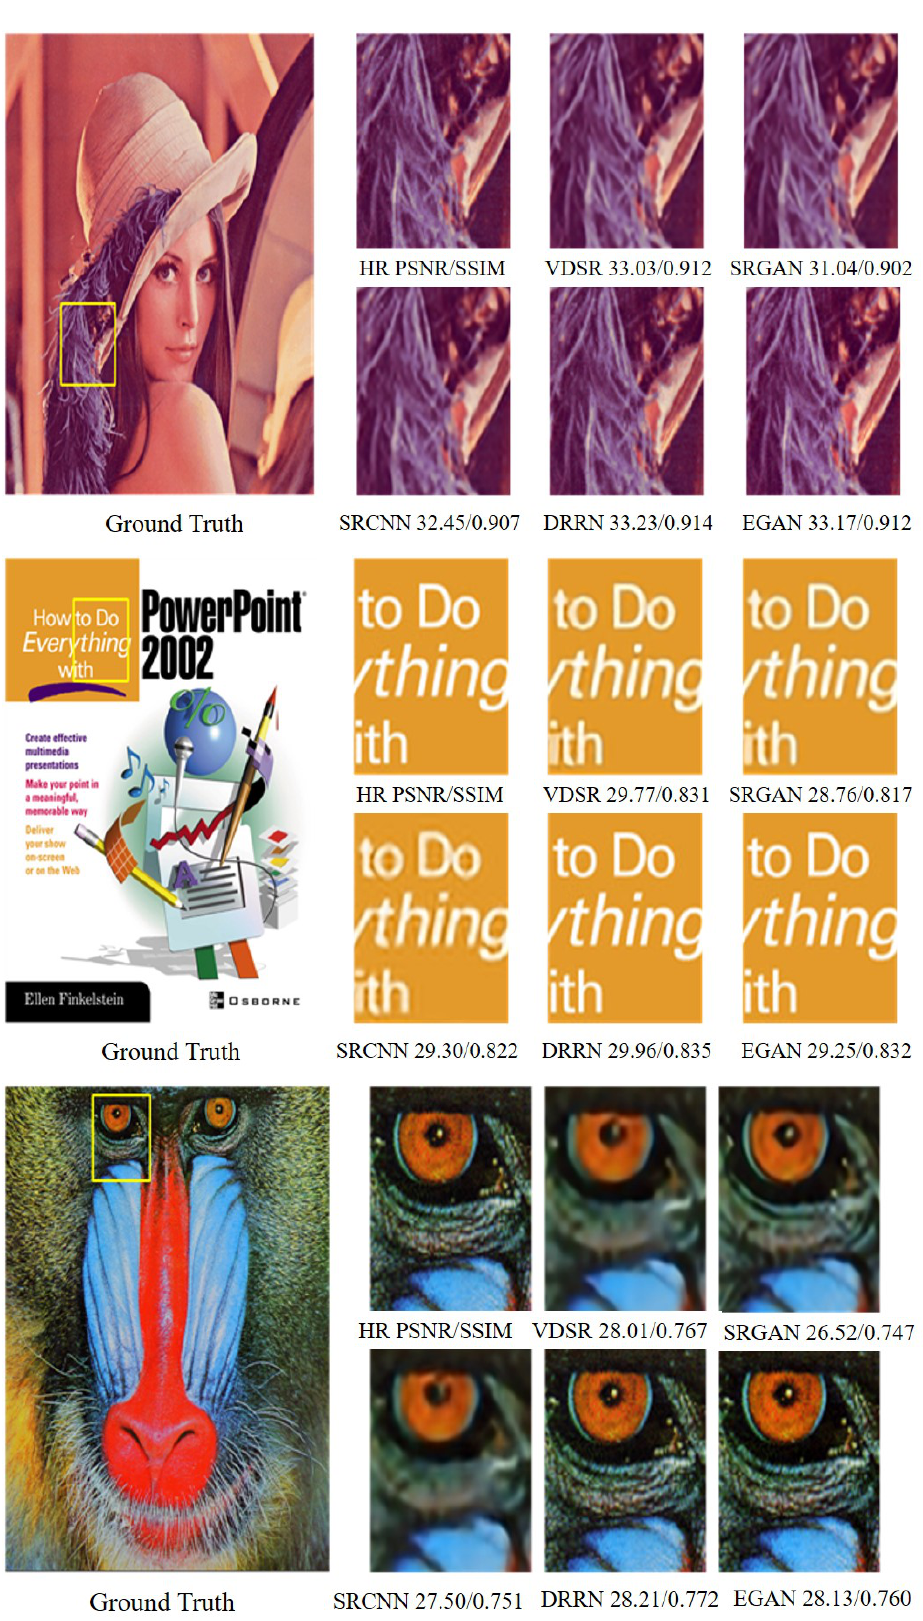
Figure 8. Visual comparisons for ×2, ×3, and ×4 SR on Set14, image “lenna” with scale factor ×2, image “ppt3” with scale factor ×3, and image “baboon” with scale factor ×4 are shown, respectively, in the 3